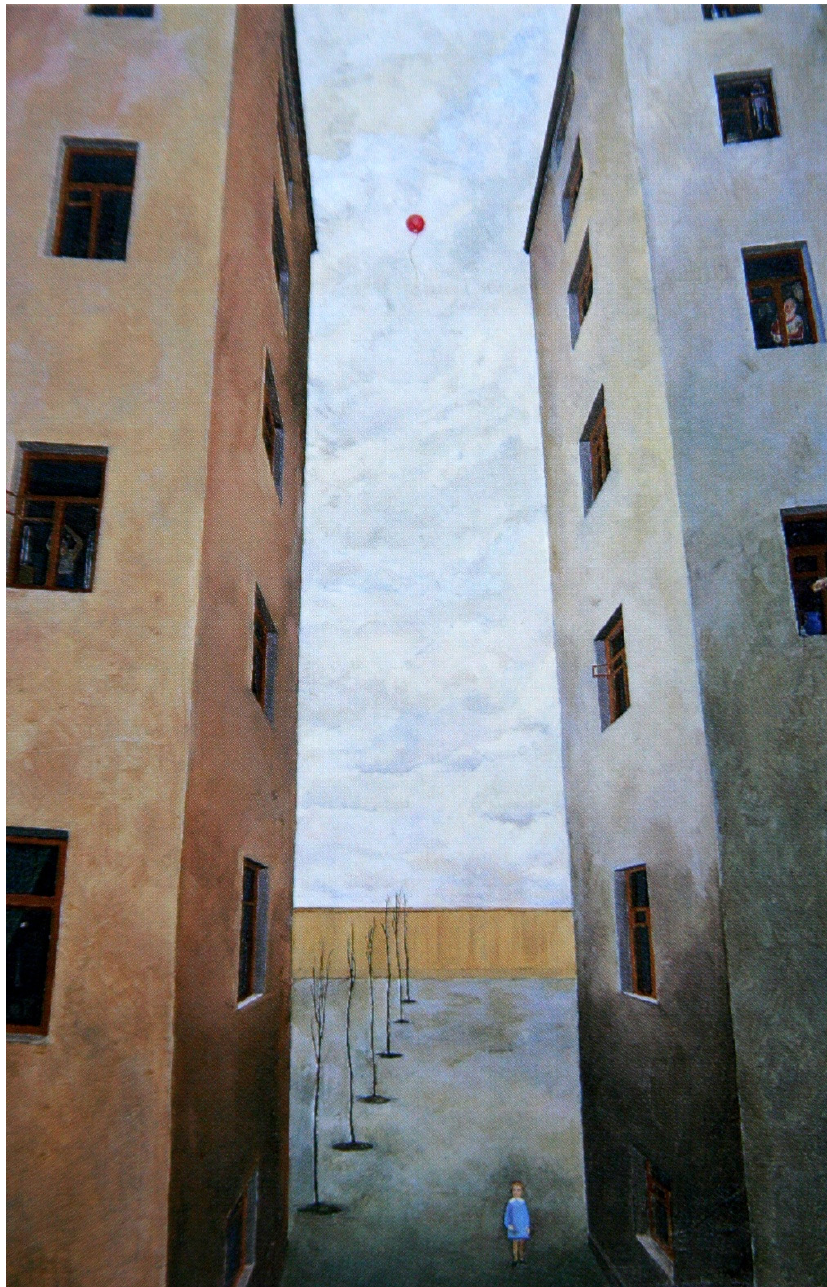
Figure 3. S. Luchishkin. The Balloon Flew Away . 1926.